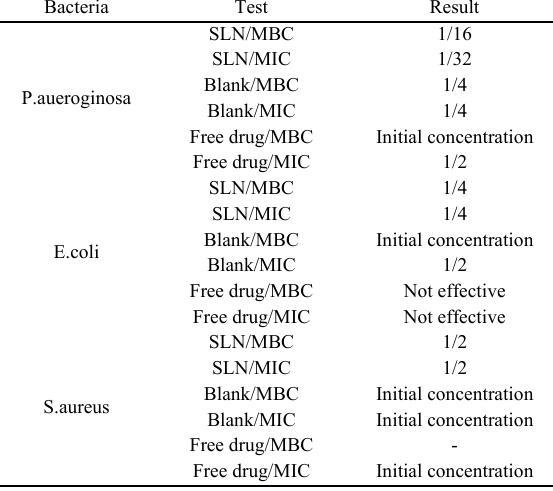
Fig. 1. SEM micrographs of sample S7 Table 3. MIC and MBC of GBE in comparison with GBE